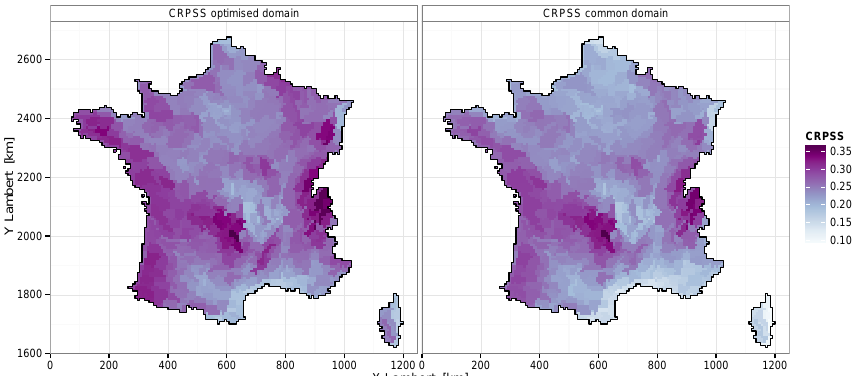
Fig. 4. Seasonal relevance maps for the Ardèche case study zone.